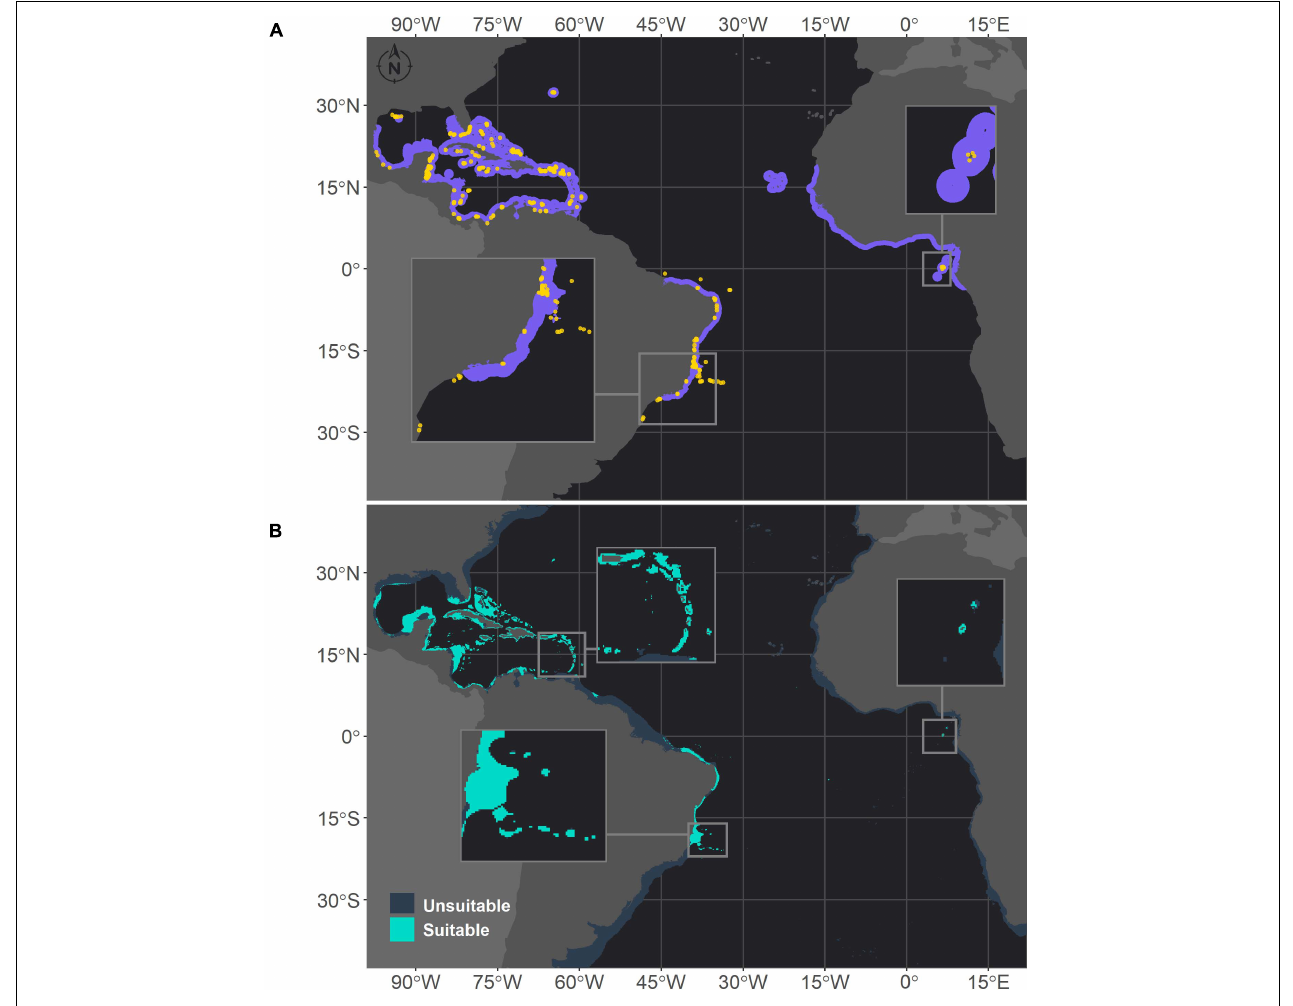
FIGURE 2 | Projected habitat suitability for Montastraea cavernosa in the Atlantic obtained through an ensemble modeling approach. Map (A) shows the presence points (in orange) used for training the model and shows (in purple) the expected range of M. cavernosa according to the IUCN. Map (B) shows the predicted habitat suitability for the current period. In both maps, inset maps highlight the Abrolhos region (left) and São Tomé islands (right), and in map (B) , the top inset highlights the Caribbean